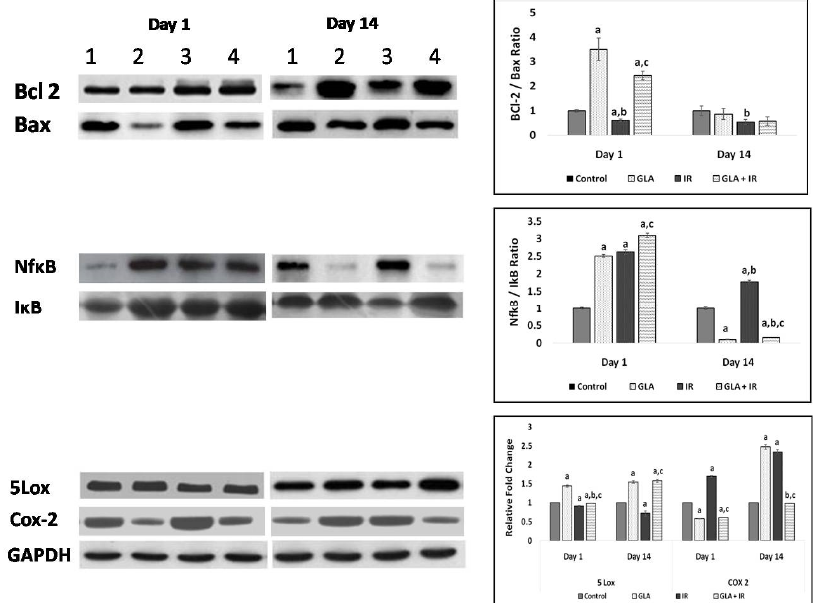
Figure 16. Effect of GLA and irradiation on protein expression (Bcl-2, Bax, Nf- κ B, I κ B, 5-LOX, and COX-2) in duodenum tissue on day 1 and day 14 post-irradiation by Western blotting. GAPDH was used as a loading control. Values (n = 3) expressed as mean ± SEM. a , b , c Significant ( p < 0.05) when compared with control, GLA, and irradiation, respectively. 1, C; 2, GLA; 3, IR; and 4, GLA + IR. C, control; GLA, gamma-linolenic acid; IR, irradiation (7.5 Gy).